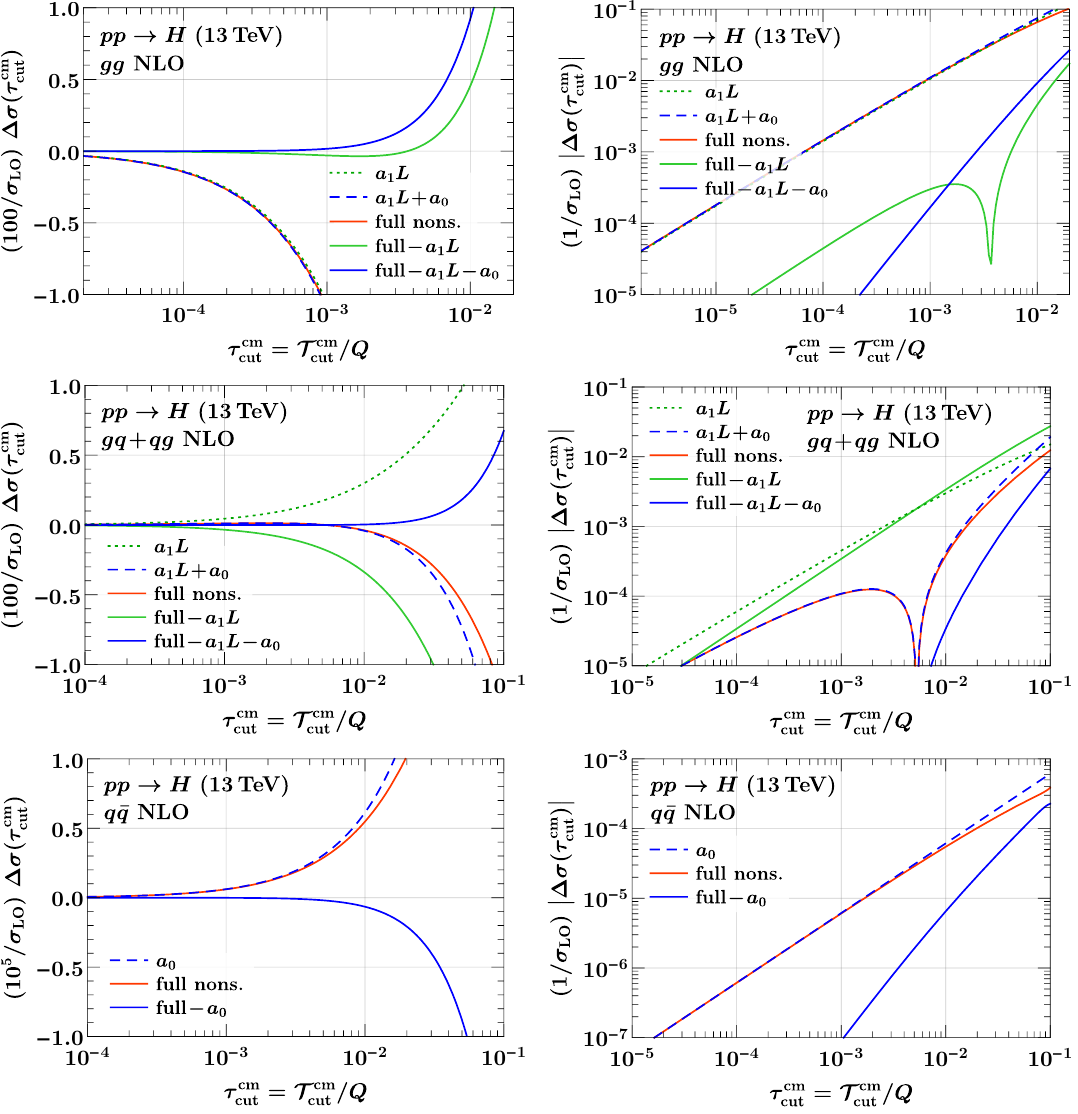
Figure 10 . Same as (cid:12)gure 8 for the hadronic T de(cid:12)nition.